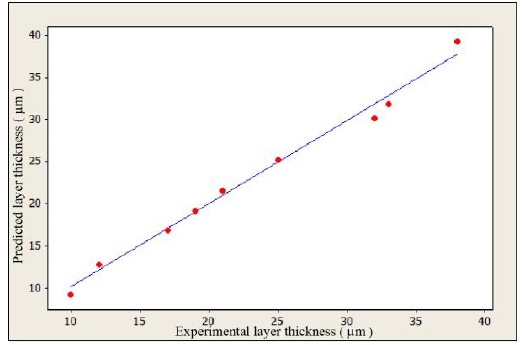
Figure 5. The correlation graph of the experimental and predicted